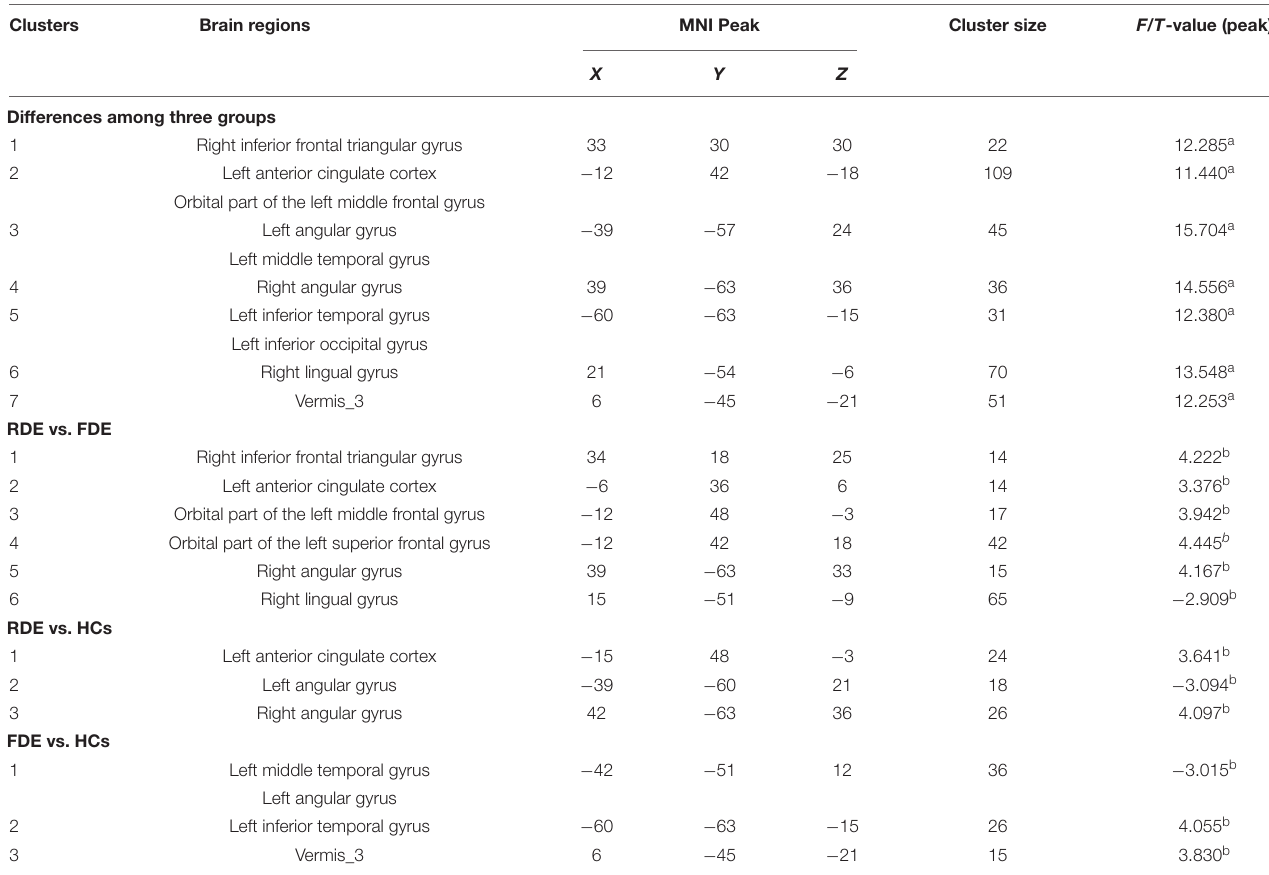
TABLE 3 | ALFF differences in RDE, FDE, and HCs. Clusters Brain regions MNI Peak Cluster size F/T -value